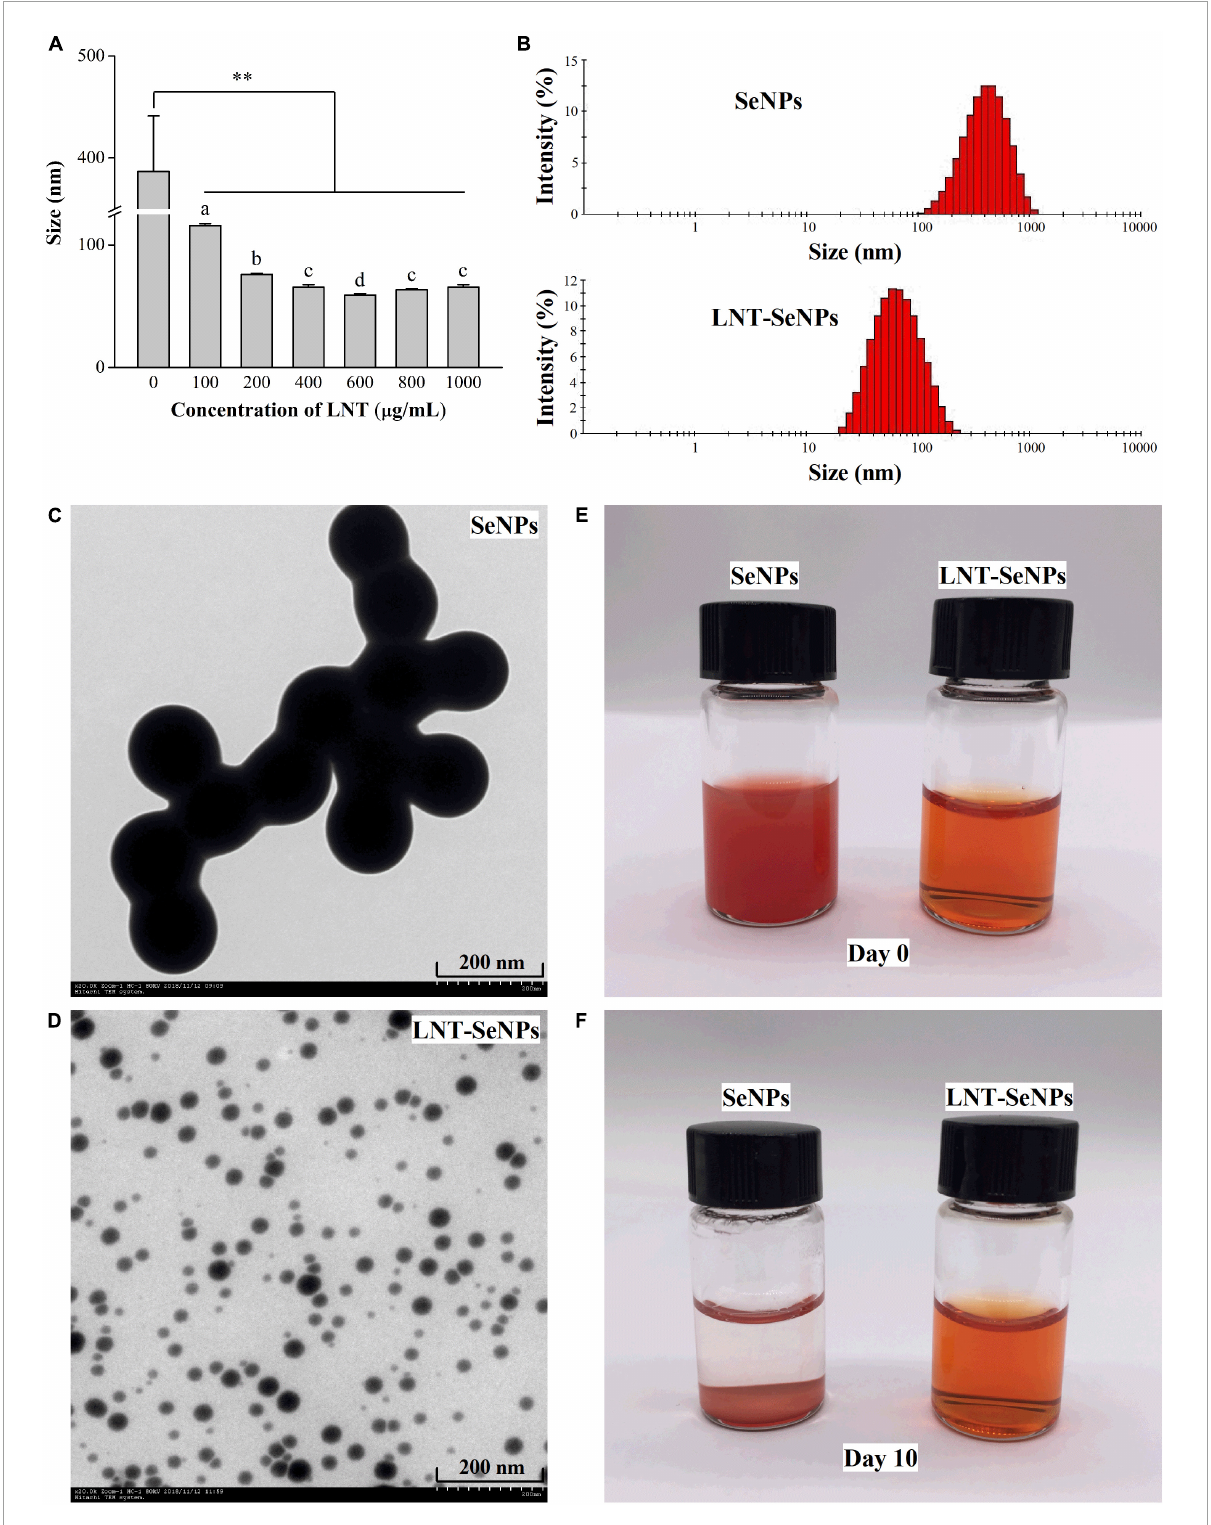
FIGURE1 The morphology feature and particle size of SeNPs and LNT-SeNPs. Average particle diameter of SeNPs prepared at different concentrations of LNT (A) ; size distribution of SeNPs and LNT-SeNPs (B) ; TEM image of SeNPs (C) and LNT-SeNPs (D) ; photographs of SeNPs and LNT-SeNPs at day 0 (E) and day 10 (F) . ** p < 0.01 represents significant difference between SeNPs alone and SeNPs with LNT as a template. Different letters represent significant difference ( p <